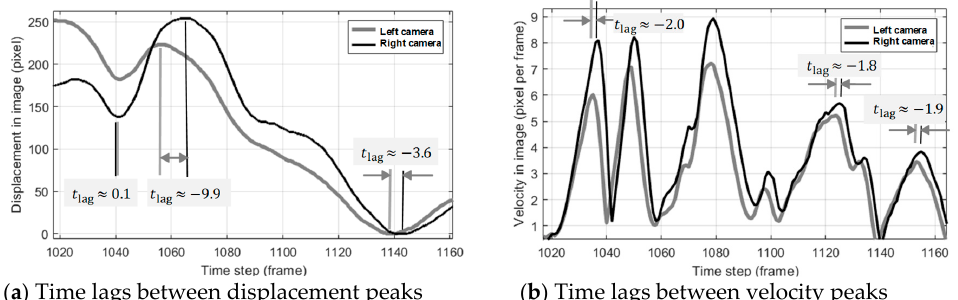
Figure 8. Comparison of synchronizations by matching moving velocity and absolute displacement. Synchronization based on velocity results in a consistency result.